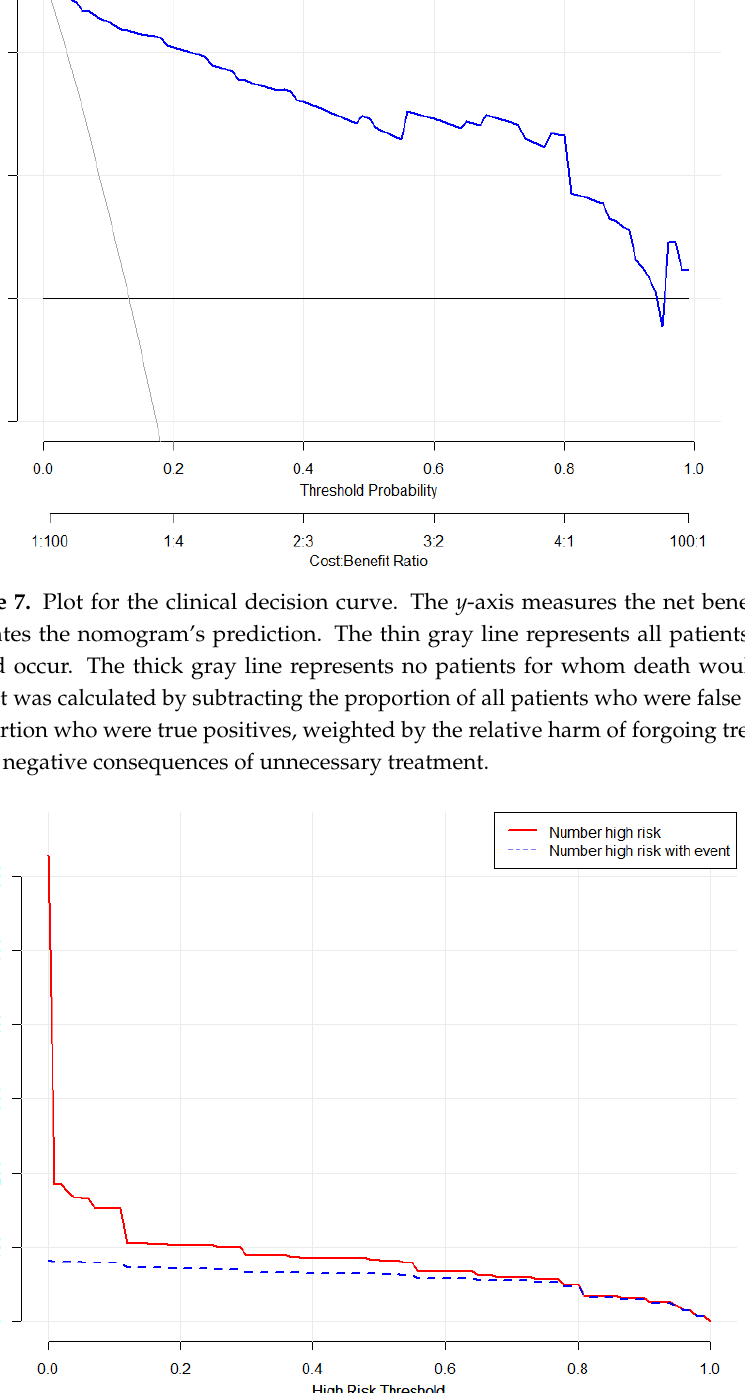
Figure 8. Plot for the clinical impact curve. The y -axis measures the number of patients with a high death probability. The red line represents the number of patients with high death probability predicted by the nomogram. The blue line represents the actual number of patients with high death probability.